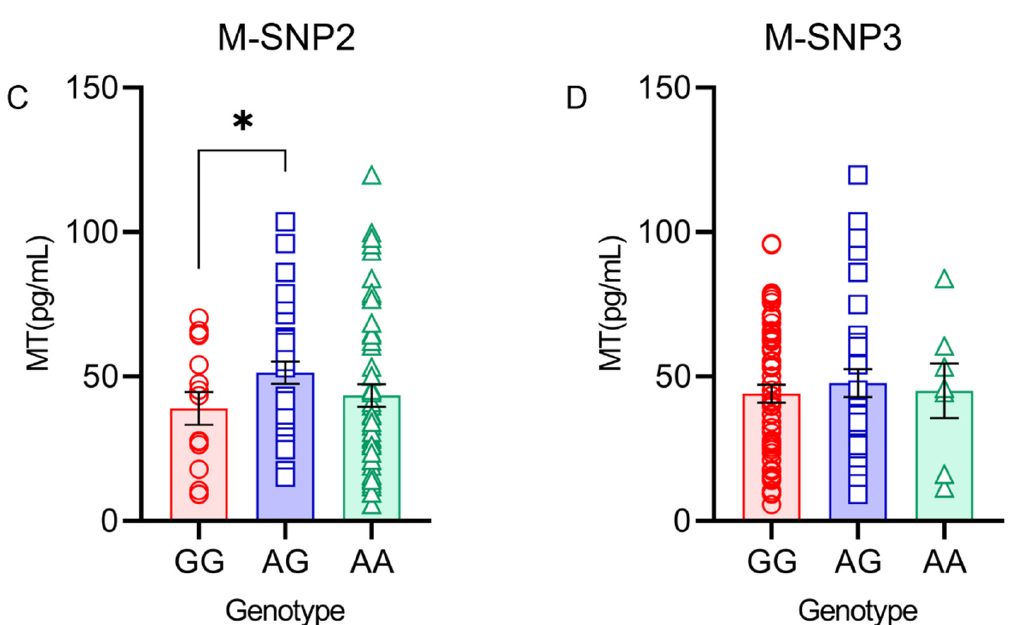
Figure 3. MT levels in milk under different genotypes within the AANAT and ASMT genes. * ( p < 0.05) show significant difference. ( A ) Milk MT level of N-SNP1 within AANAT . ( B ) Milk MT level of M-SNP1 within ASMT . ( C ) Milk MT level of M-SNP2 within ASMT . ( D ) Milk MT level of M-SNP3 within ASMT .